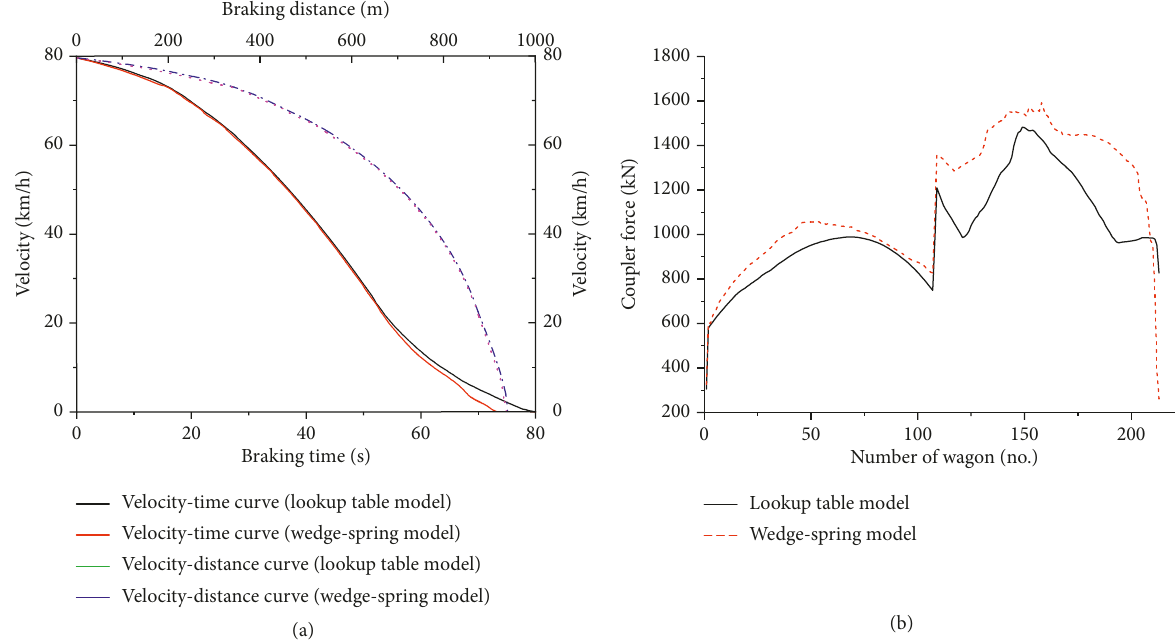
Figure 10: Simulation results of 170kPa applied full-braking condition. (a) Velocity variation curve. (b) Number of wagon with maximum coupler force.